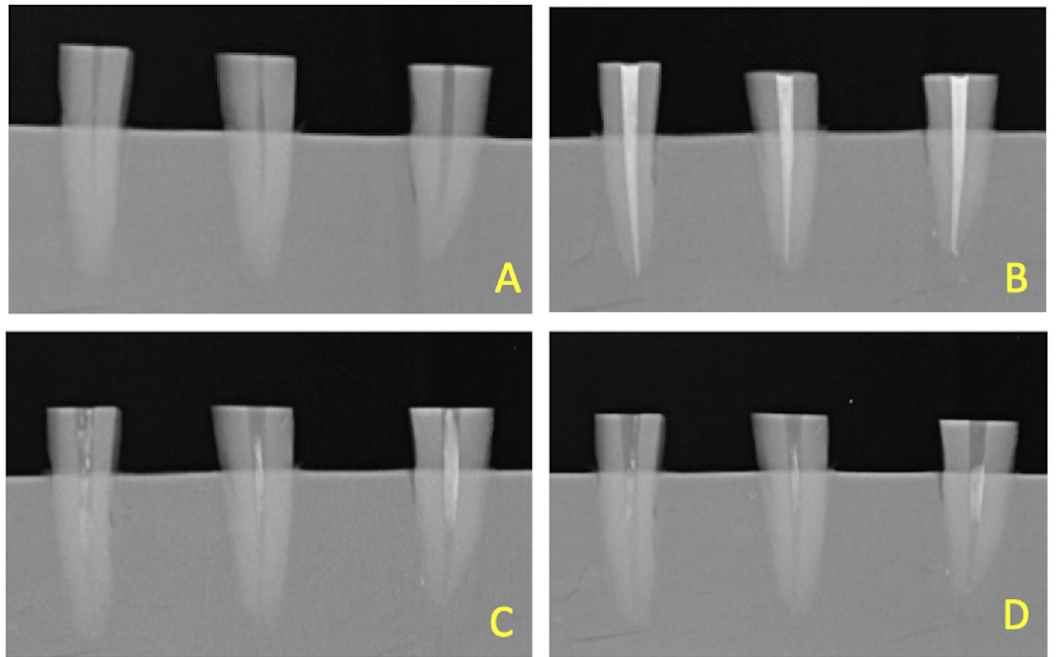
Figure 3. Radiographic examination of customized mold with three teeth before treatment ( A ), after root canal filling ( B ), after retreatment with RB #25, ( C ) and after retreatment with RB #40 ( D ).